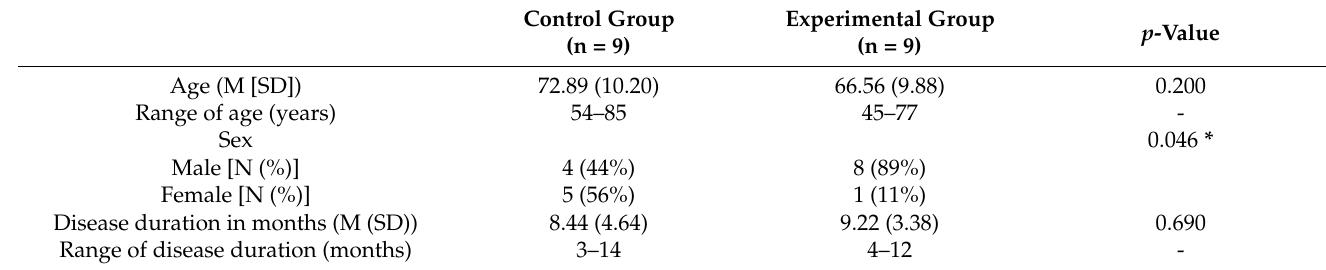
Table 1. Sociodemographics of control and experimental groups (n =